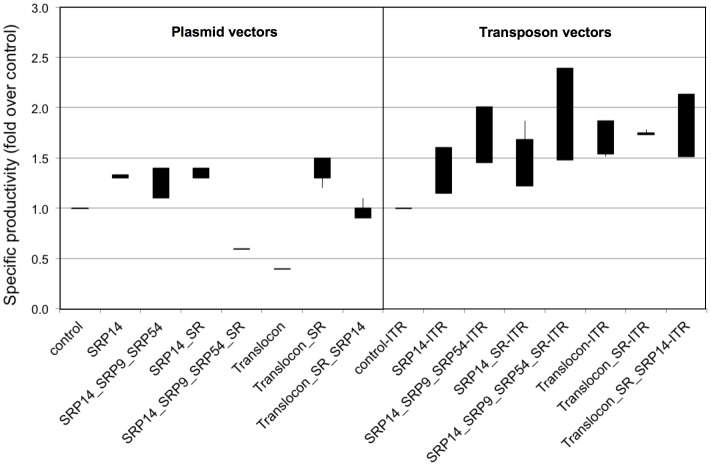
Effect of the expression of secretion proteins from transposable and plasmid vectors on recombinant protein expression.(A). Transposable or regular plasmid vectors were constructed to express secretion proteins SRP9, SRP14, SRP54, the SRP receptor a and b subunits (SR), or the Translocon. Transposable vectors were co-transfected with the piggyBac transposase vector, whereas the non-transposable plasmid vectors were transfected alone in a cell clone expressing the infliximab antibody [22]. After three weeks of culture without selection, the levels of secreted infliximab antibody were assayed from cell culture supernatants. Data pertaining to the effect of transposable vectors are as in [22].